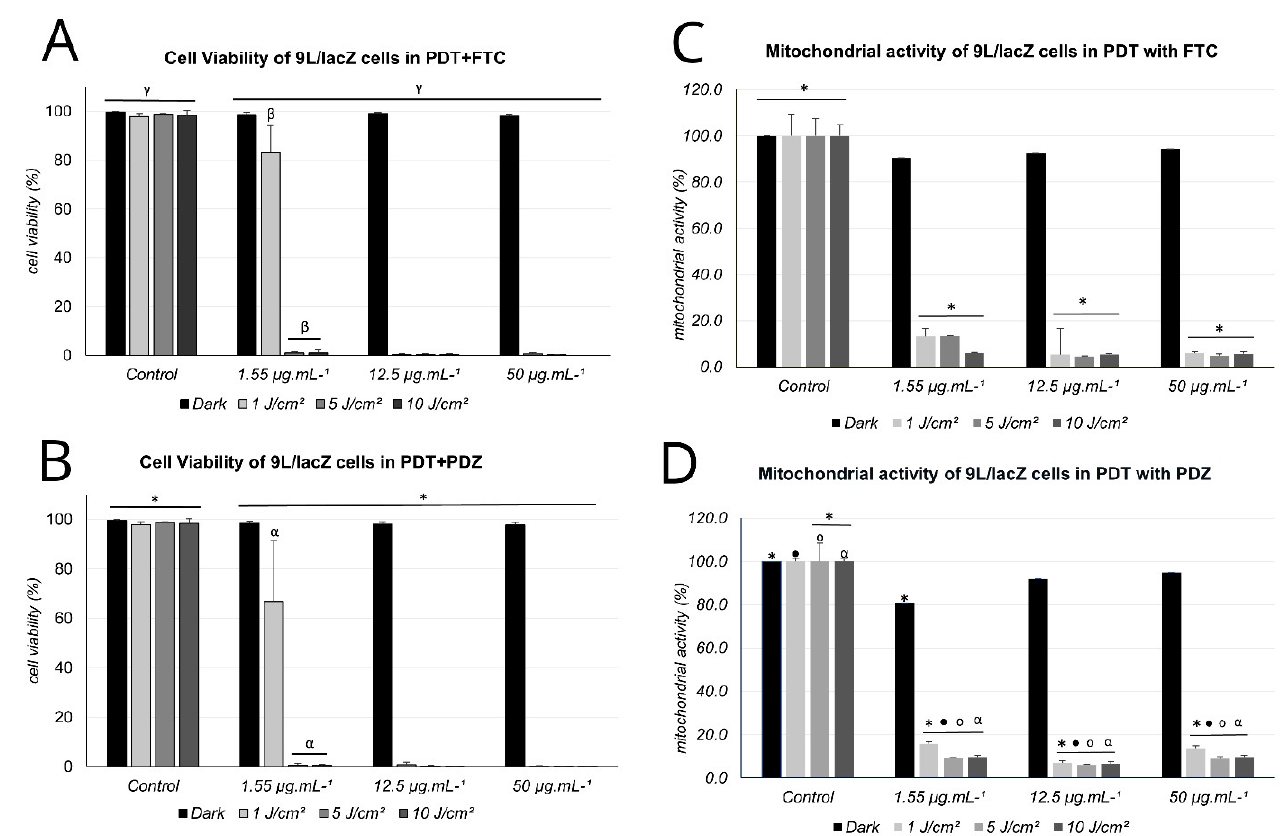
Figure 3. ( A ) — Cell viability evaluated by the exclusion test with Trypan Blue in the control and incubated with FTC, dark and irradiated groups. ( B ) — Cell viability evaluated by the Trypan Blue exclusion test in the control and PDZ-incubated, dark and irradiated groups. Symbols for p < 0.01: γ, β, * and α. ( C ) — Mitochondrial activity evaluated by the MTT test in the control and incubated with FTC, dark and irradiated groups. ( D ) — Mitochondrial activity evaluated by the MTT test in the control and incubated with PDZ, dark and irradiated groups. Symbols for p < 0.01: *, •, ⚬ and α.